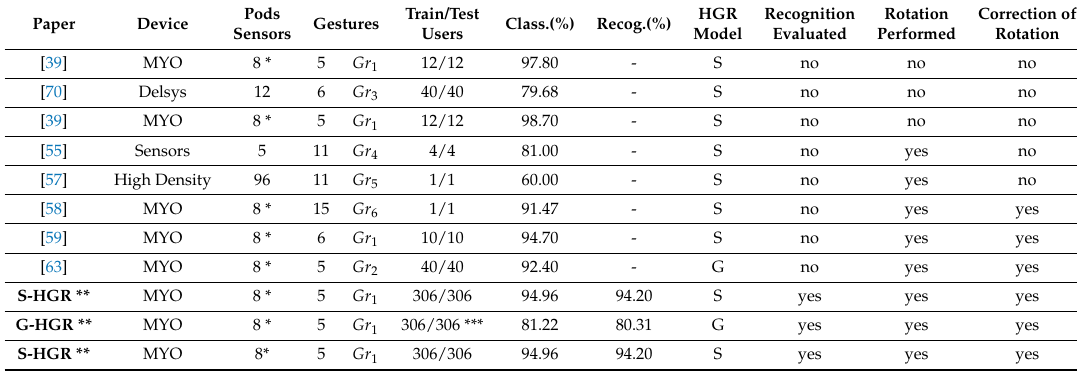
Table 12. Classification and recognition